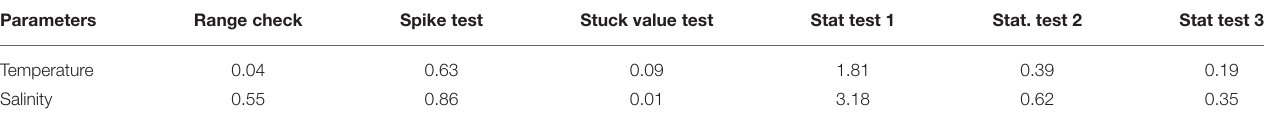
TABLE 3 | Mean percentages of detected anomalies obtained from all mooring time series in the various reprocessing steps. Parameters Range